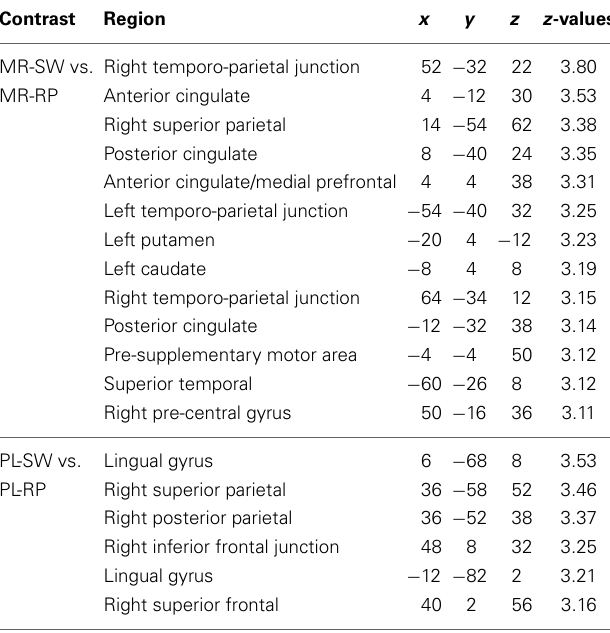
Table 1 | Brain regions showing significant activations during switch trials relative to repeat trials in pre-training session.